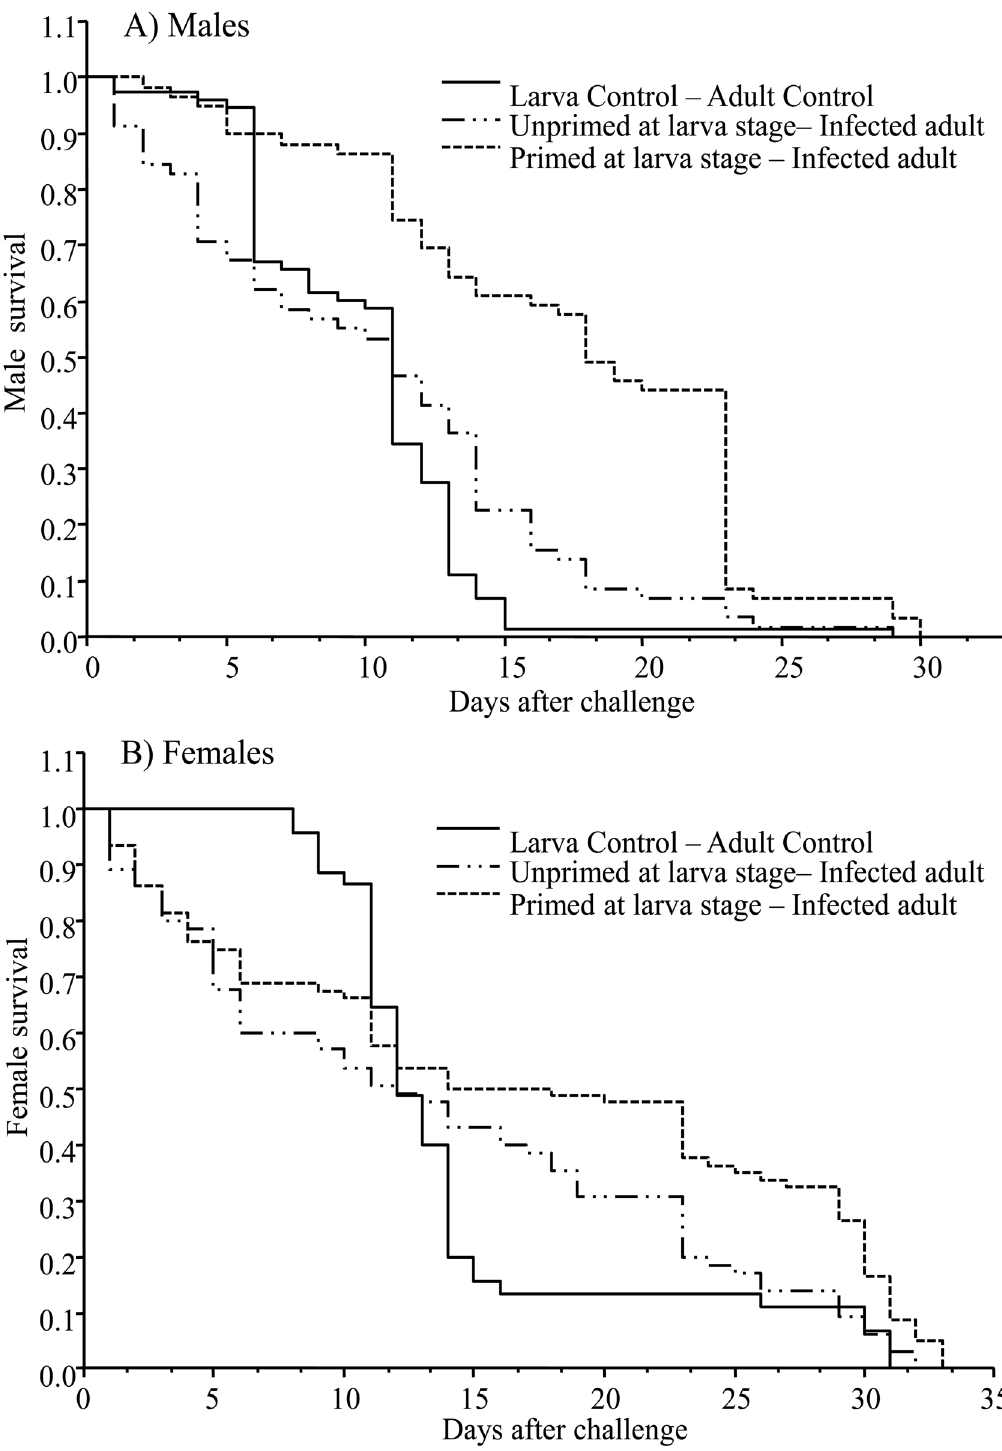
Fig 2. Survival curves of mosquitoes of the C, UnPr, and Pr groups after the challenge in adults. (A) Males and (B) females.